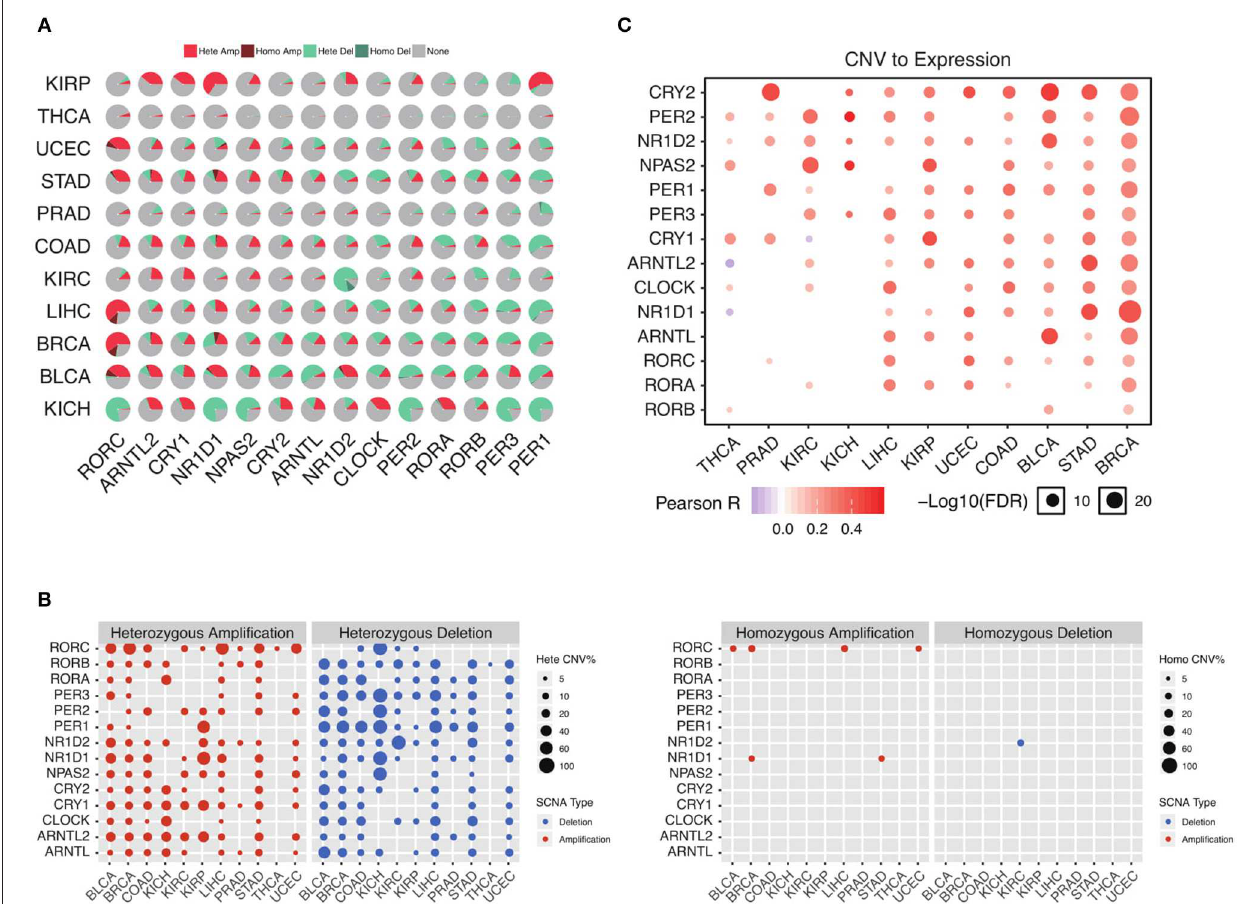
FIGURE 2 | Heterozygous deletion underlies the circadian clock dysregulation. (A) The proportion of each copy number variation in cancers. (B) Heterozygous and homozygous amplification/deletion of circadian clock genes in cancers. (C) Copy number variation strongly associates with gene expression of circadian clock.